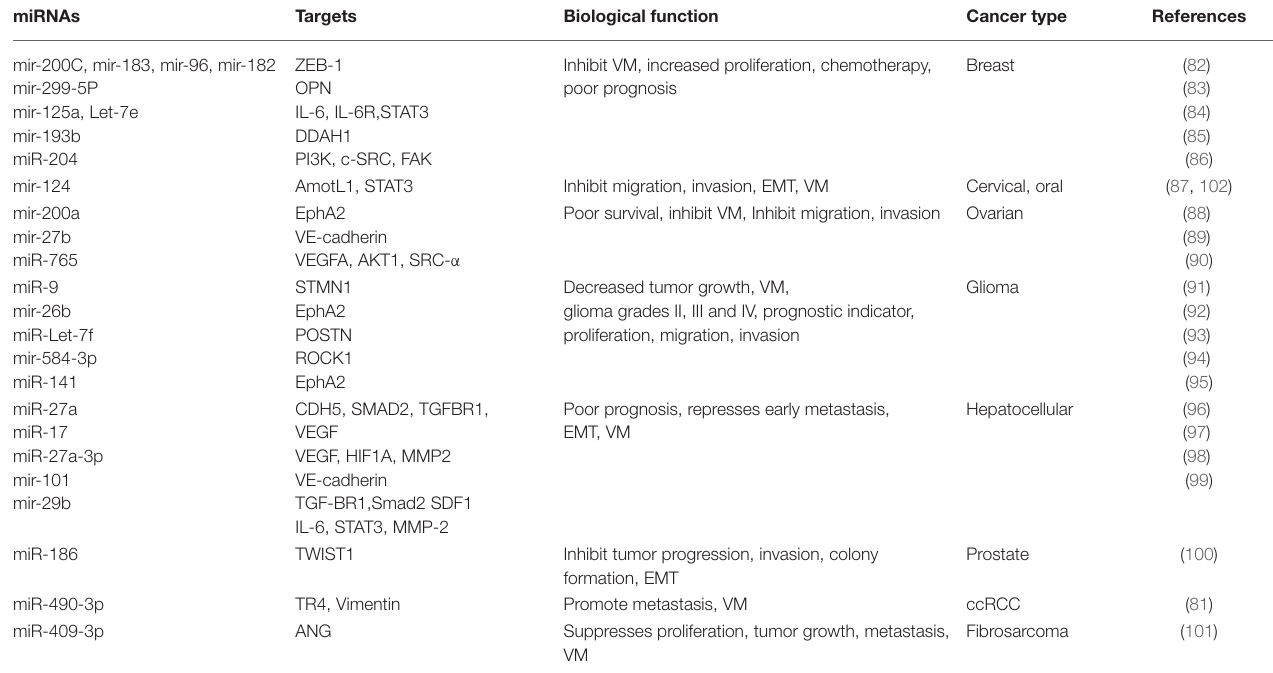
TABLE 2 | Modulation of VM by microRNAs (miRNAs).